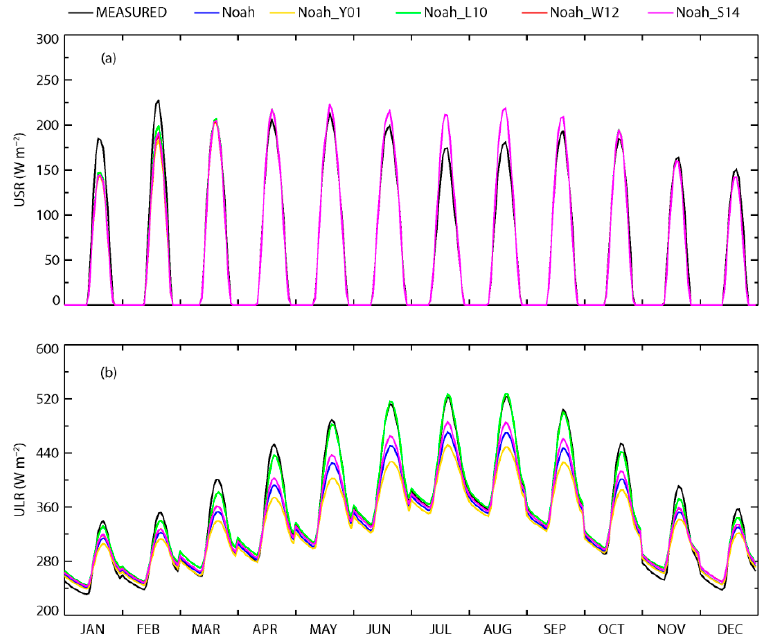
Figure 3. Simulated and observed monthly mean diurnal cycles of ( a ) upward shortwave radiation (USR) and ( b ) upward longwave radiation (ULR). Table 3. Coefficients of correlation (R), model efficiency index (NSE), mean bias error (MBE), and root mean square error (RMSE) between observation and simulation of upward shortwave and longwave radiations.